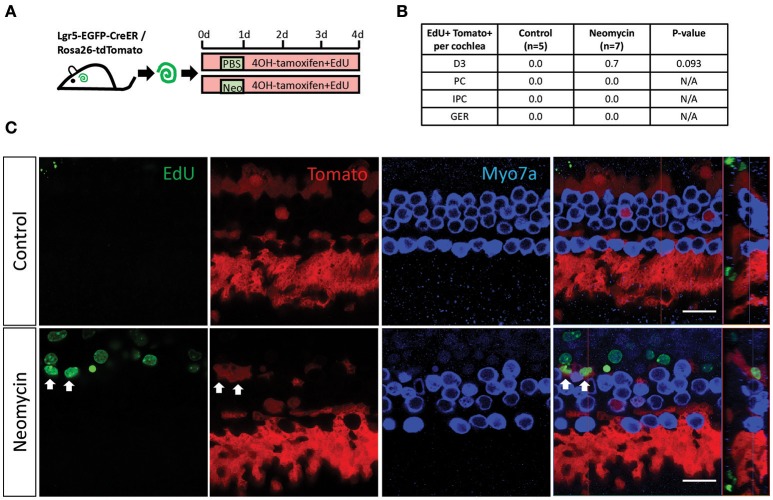
EdU labeling measures the proliferation of Lgr5+ cells in the neomycin-treated and untreated cochleae of postnatal mice. (A) 4OH-tamoxifen and EdU were added to the culture medium of P1 Lgr5-EGFP-creER/Rosa26-tdTomato mouse cochleae throughout the culture period. Neomycin was added at 12 h after the start of the culture and was allowed to incubate for 12 h, and the same amount of PBS was added to the untreated cochleae culture medium for the same amount of time. The cochleae were examined after 4 days of culture. (B) All of the tdTomato+/EdU+ cells found in the neomycin-treated cochleae and the untreated cochleae were counted and statistically analyzed. The p = 0.093, n is shown in parentheses. D3, the third-row Deiters' cells; PC, inner pillar cells; IPC, inner phalangeal cells; GER, the lateral greater epithelial ridge. (C) Images of the neomycin-treated and untreated cochleae show that tdTomato+/EdU+ cells were found in the neomycin-treated cochleae (arrows). Scale bars are 20 μm in (B).